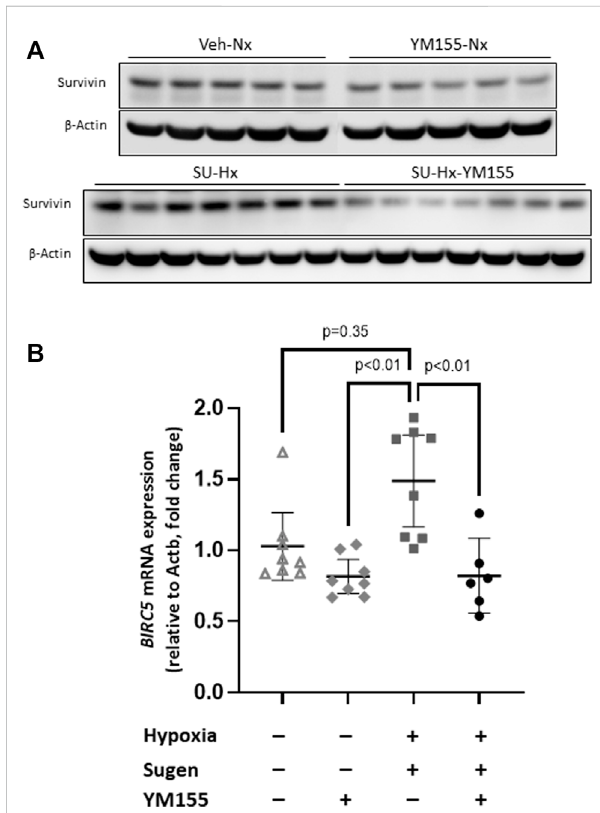
FIGURE 5 Effect of YM155 on survivin protein and mRNA expression in whole lung extracts of SU5416/hypoxia-induced PAH mice. (A) Immunoblots of the expression of survivin and the constititutive protein ß -actin in the different experimental groups (Veh-Nx = vehicleandnormoxia;YM155-Nx=vehicle,normoxiaandYM155;SU- Hx = SU5416 and hypoxia; SU-Hx-YM155 = SU5416, hypoxia and YM155). (B) Quantitative mRNA expression of BIRC5, the gene encoding survivin, related to Actb expression using RT-PCR in the different experimental groups. Values are expressed as median (IQR) and statistical signi fi cance was assessed by the Kruskal – Wallis test.